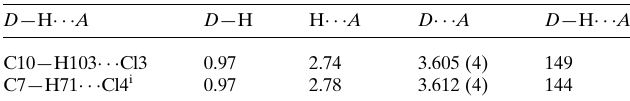
Table 3 Hydrogen-bond geometry (A˚ , (cid:2) ) for 2 .